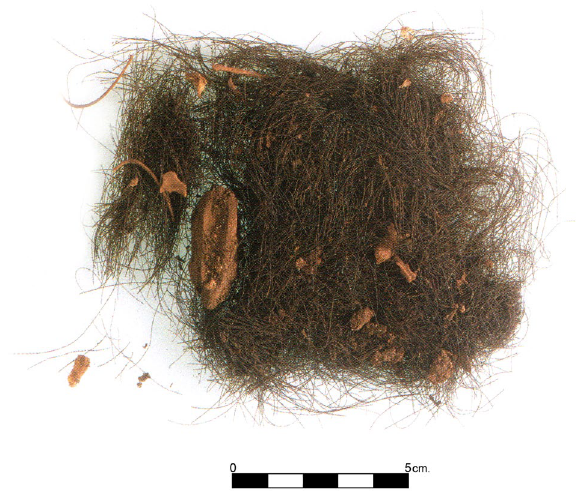
Figure 4. Human hair strands deposited in the trilobed container, and some microfaunal bones attached to the locks (Photo P.